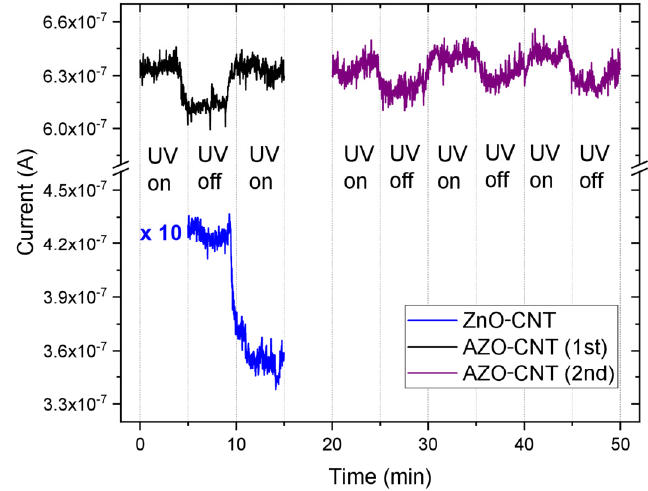
Figure 6. Current flowing at 2 mV through an AZO–CNT layer (AZO:CNT weight ratio = 4.2) during UV light irradiation cycles as a function of time. 1st refers to one cycle, while 2nd refers to other consecutive UVon/UVoff cycles. For comparison, the current flowing at 3 mV in a similar sample containing ZnO-decorated CNTs (ZnO:CNT weight ratio = 11) is also reported. The current values reported for ZnO:CNT are multiplied by a factor of 10 to compare them in the same graph with the values obtained for AZO–CNT layers.